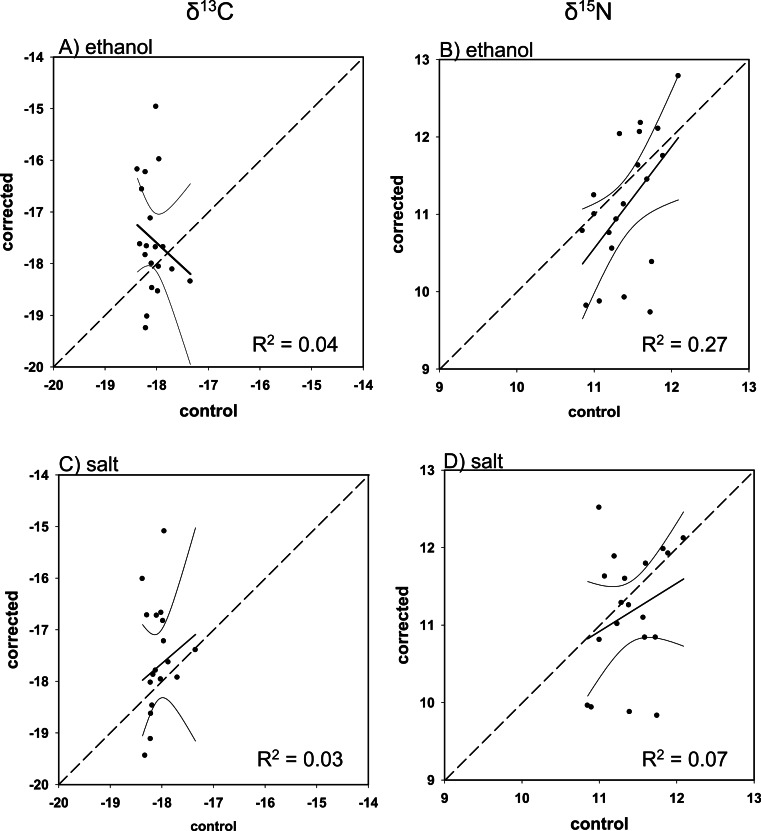
Mass balance corrected values against control values for L. campechanus.The 1:1 line (hashed), predicted (solid), and 95% confidence intervals are given for (A) ethanol δ13C, (B) ethanol δ15N, (C) salt δ13C, and (D) salt δ15N.